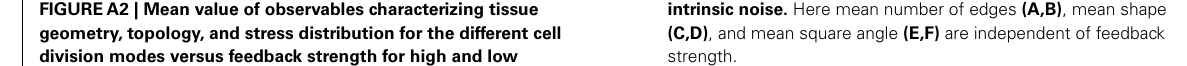
intrinsic noise. Here mean number of edges (A,B) , mean shape (C,D) , and mean square angle (E,F) are independent of feedback